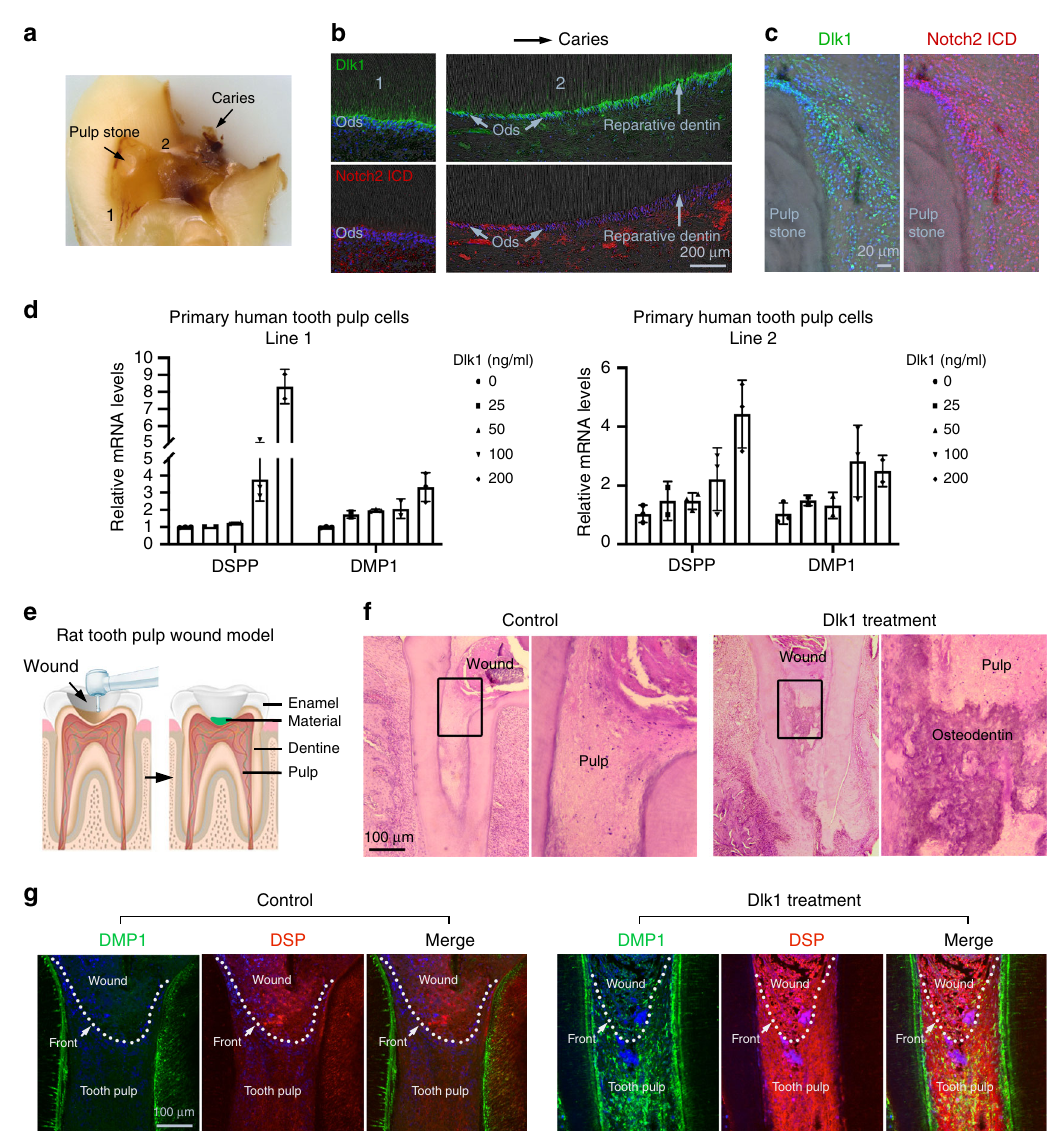
Fig. 9 A translational strategy of applying Dlk1 in dental regenerative medicine. a Representative cross-sectional view of a human tooth with caries in paraf fi n- embedded block. Arrows indicate the caries site and a pulp stone in the tooth pulp. 1 indicates a relative healthy region and 2 indicates an adjacent region near the caries. b , c Immuno fl uorescent analysis of Dlk1 and Notch2 expression in the same sample of a , at different regions of the tooth. Pulp stone images were overlapped with phase contrast images to illustrate the stone location. d DSPP and DMP1 mRNA expression analysis with real-time RT-PCR in two independent human tooth pulp papilla cell lines treated with soluble Dlk1 at indicated concentrations ( X axis). mRNA were extracted from n = 3 biologically independent samples. e Schematic illustration of the design of rat molar tooth capping model. f , g Representative H&E ( f ) and immuno fl uorescence ( g ) analyses of the rat molars received capping without (control) and with Dlk1 treatment for 7 days. Samples were immunolabelled for DMP1 and DSP and counterstained with DAPI. White dotted lines mark the wound fronts. Error bars represent standard deviation. Bars: b : 200 μ m; c : 20 μ m; f , g : 100 μ